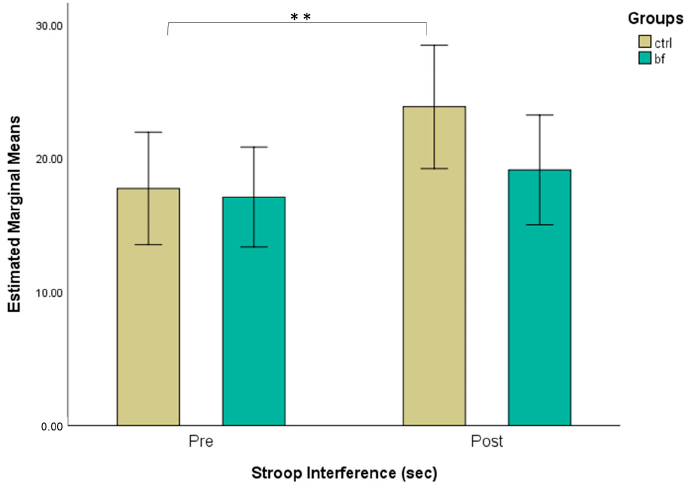
Figure 3. Estimated marginal means (with 95% confidence intervals) for Stroop Interference pre- and post-intervention across groups (**— p < 0.01— t -test for dependent samples).